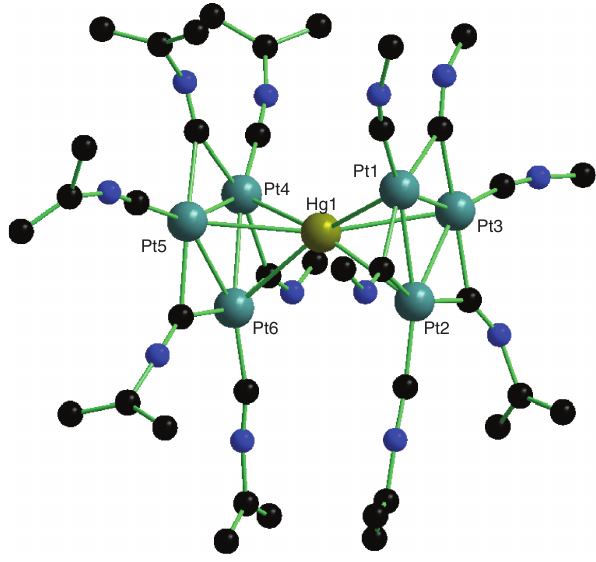
Figure 1 Simplified view of the molecular structure (diamond) of [{(CNxyl) ( μ -CNxyl) Pt } Hg] (Yamamoto et al., 3 3 3 2